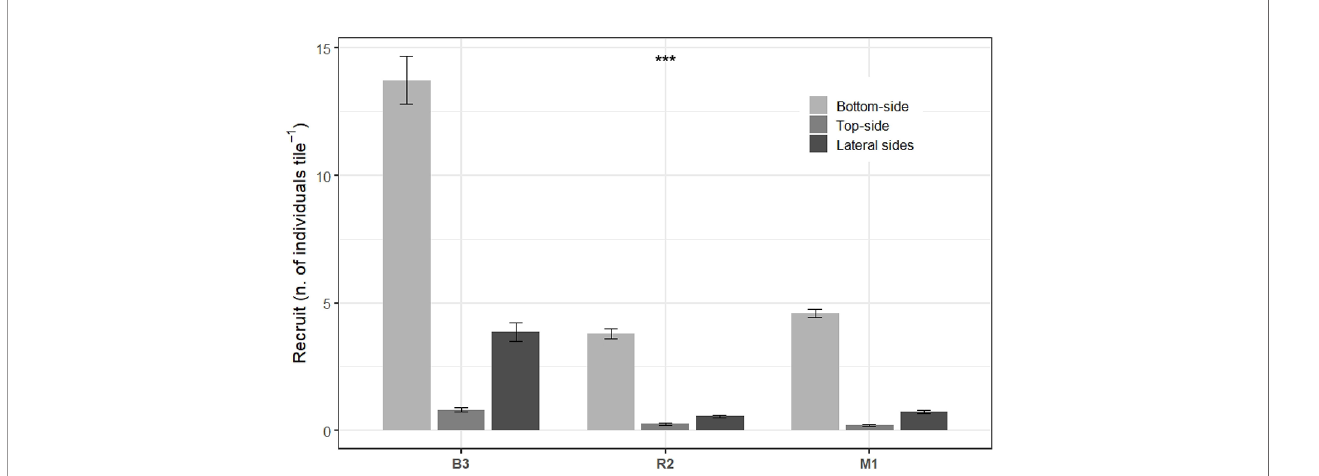
FIGURE 4 | Number of coral recruits (per tile) found on the different sides of the tiles immersed during ca. two years at Bourake ́ (B3) and stations R2 and M1. Data are means ± SD (number of tiles n = 15, 20, and 19, for B3, R2, and M1, respectively). Data from the lateral sides were pooled. Stars represent statistical signi fi cance (see Table S3